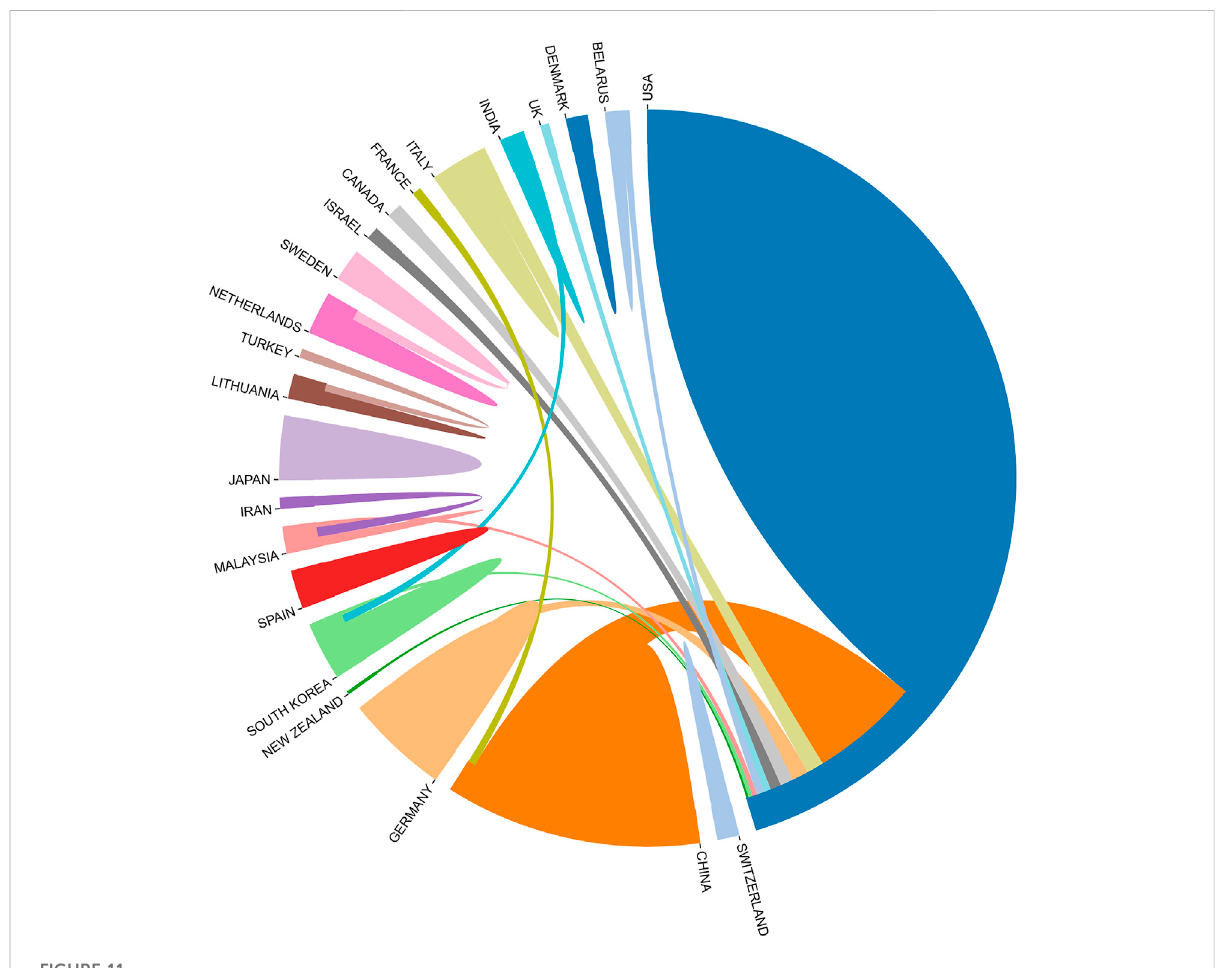
FIGURE 11 Country-to-country relations of Top 100 Most-cited Articles.